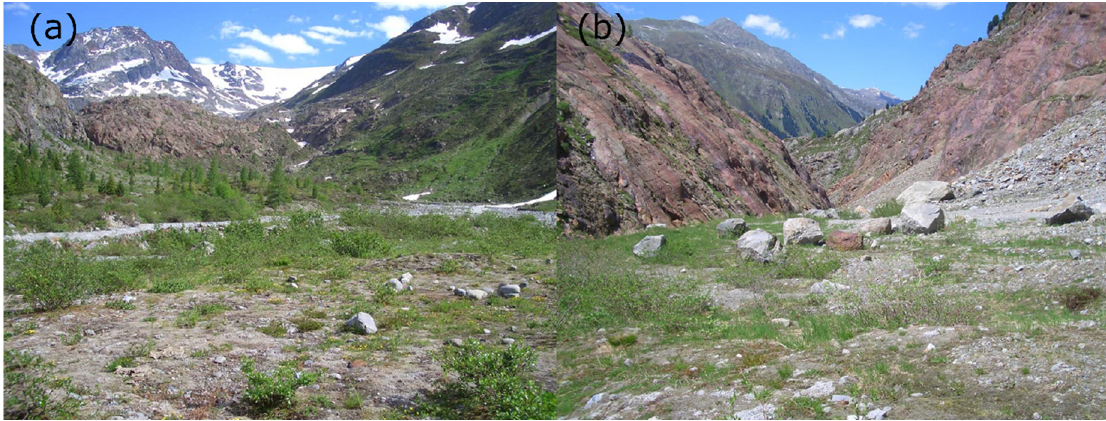
Figure 6. Typical habitats of Pterostichus adstrictus in the Kaunertal (Ötztal Alps, Austria): gravel bank ( a ), moraine ( b